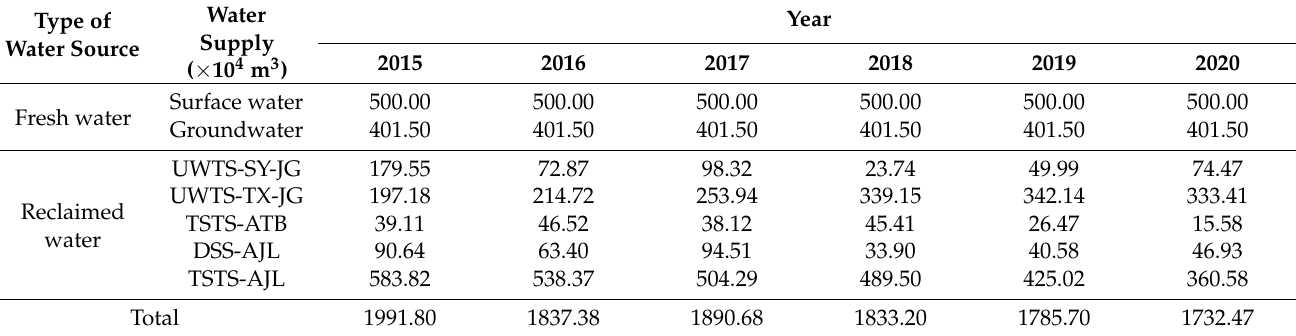
Table 1. Water supply of the study area from 2015 to 2020. UWTS-SY-JG denotes an